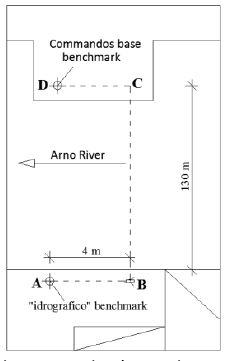
Figure 12. Altimetric connection by reciprocal leveling between two benchmarks placed on opposite sides of the Arno river For this purpose, a Wild NA2 level with a Wild GPM3 parallel plate micrometer, and two Wild GPLE2 double graduation invar leveling rods, have been used.